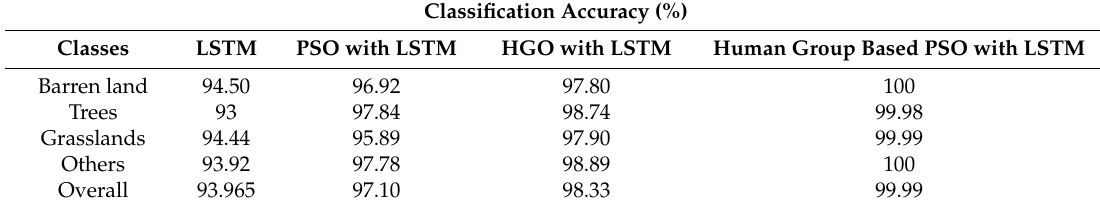
Table 7. Performance investigation of the proposed model with different optimization techniques on Sat 4 dataset by means of classification accuracy.